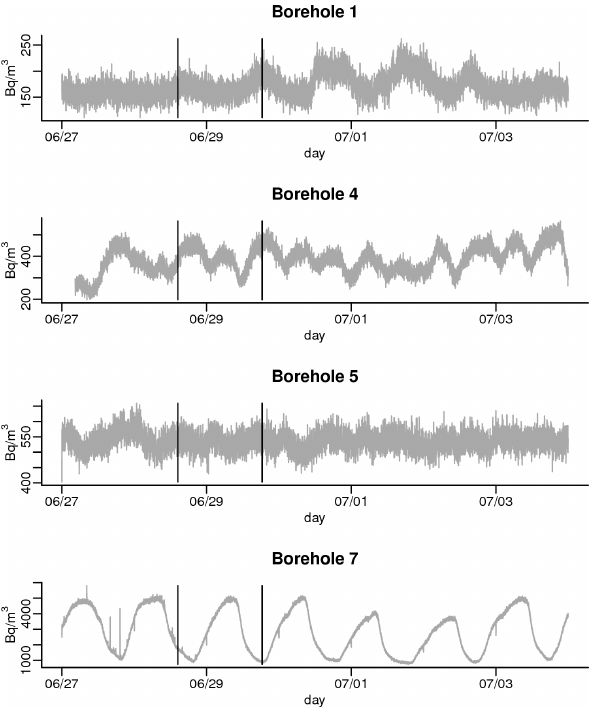
Fig. 4. Time series (1-min rate) of radon concentration for the pe- riod from 27 June to 3 July. The vertical solid lines indicate the time of explosions in the